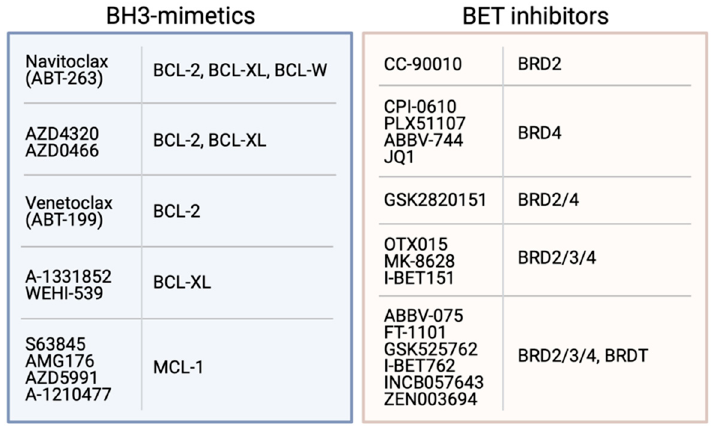
Figure 3. Examples of BH3-mimetics and their BCL-2 pro-survival proteins targets, and BET inhibitors with their BRD protein targets.